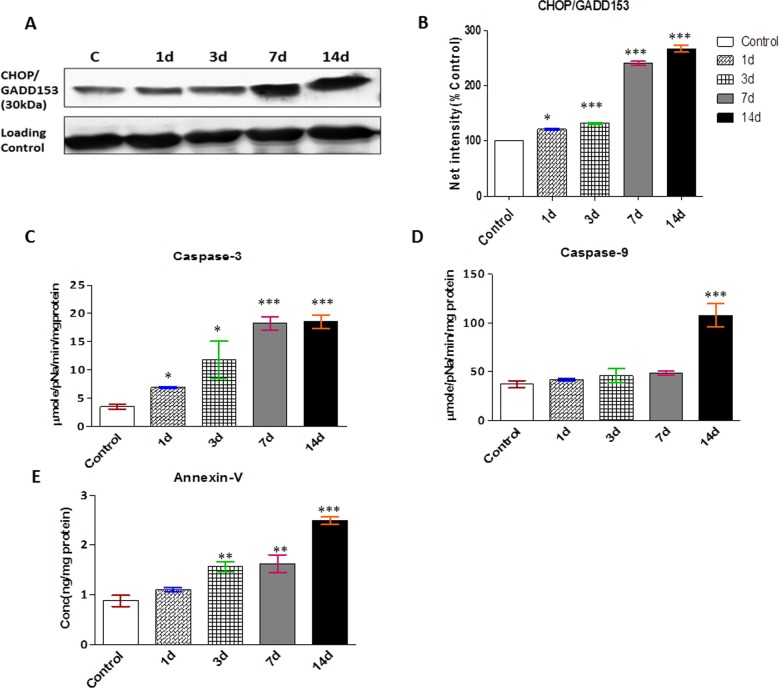
Chronic hypoxia led to the activation of apoptotic signaling cascade.(A) Representative western blots for expression of CHOP/GADD153 from the cytoplasmic extracts of skeletal muscle. (B) Semiquantitative analysis of the expression of ER associated degradation, CHOP/GADD153. GAPDH considered as the loading control. The densitometric analysis is shown as mean with standard error (bars) performed in n = 3 independent experiments. Specific colorimetric peptide substrate has been used for particular caspases in cellular fuction. Activity of caspase-3 and caspase-9 was measured using colorimetric substrate Ac-Asp-Glu-Val-Asp p-Nitroaniline and Ac-Leu-Glu-His-Asp-pNA. The cysteine protease activity of (C) Caspase-3 and (D) Caspase-9 cleaves the substrate and releases pNA, the absorbance of which can be measured at 405 nm, and the (E) Annexin-V was measured by ELISA kit. All values presented as mean ± SEM. *p<0.05 Vs. Control; **p<0.01 Vs. Control; ***p<0.001 Vs. Control.